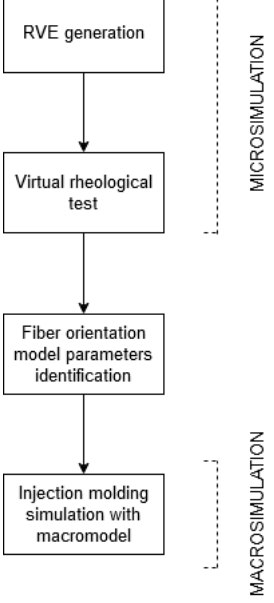
Figure 1. Multi-scale simulation process for short fiber reinforced thermoplastics (SFRT). RVE, representative volume